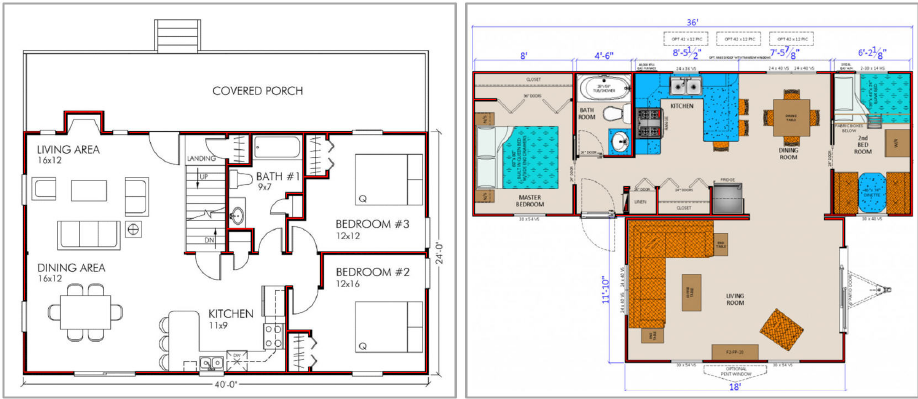
Figure 13. Floorplan vectorization results (red line) on an image from the internet (without object detection).